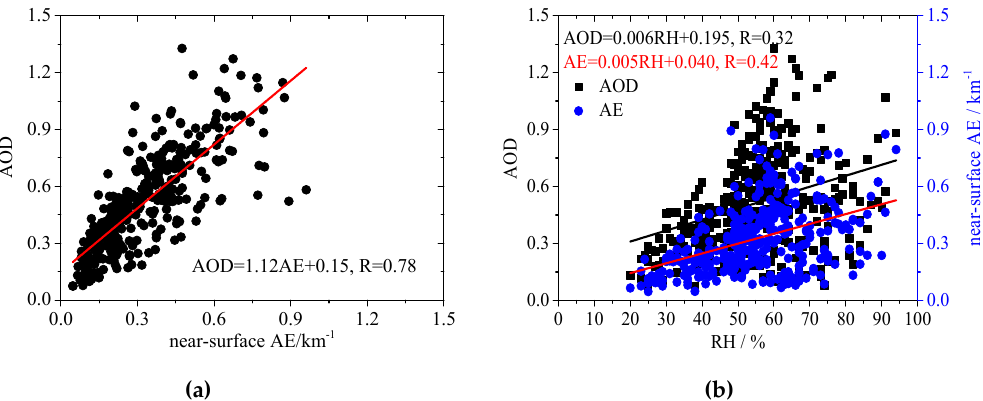
Figure 4. Correlations of the qualified hourly average MAX-DOAS results and meteorological variables: ( a ) correlation between AOD and near-surface AE; ( b ) correlation between AOD (near-surface AE) and RH. The equations of linear regression and corresponding correlation coefficients (R) are also shown in Figure 4a,b.